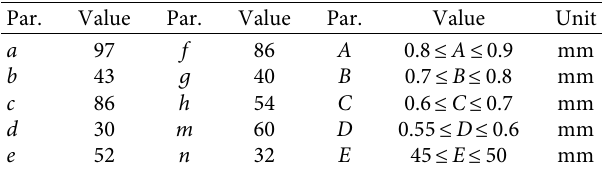
Table 1: Dimensions of the XYθ microrobotic platform (unit: mm).